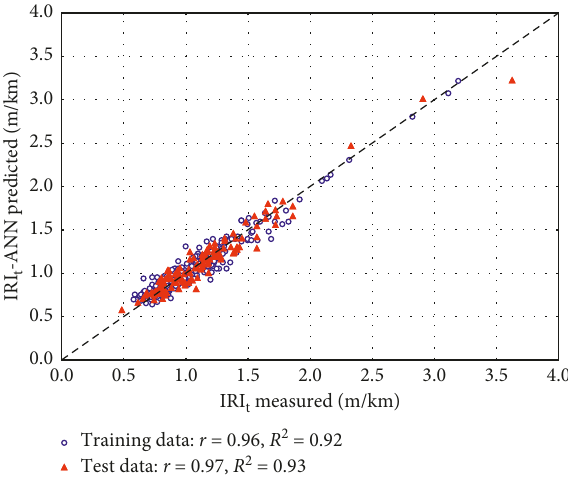
t using the ANN model: